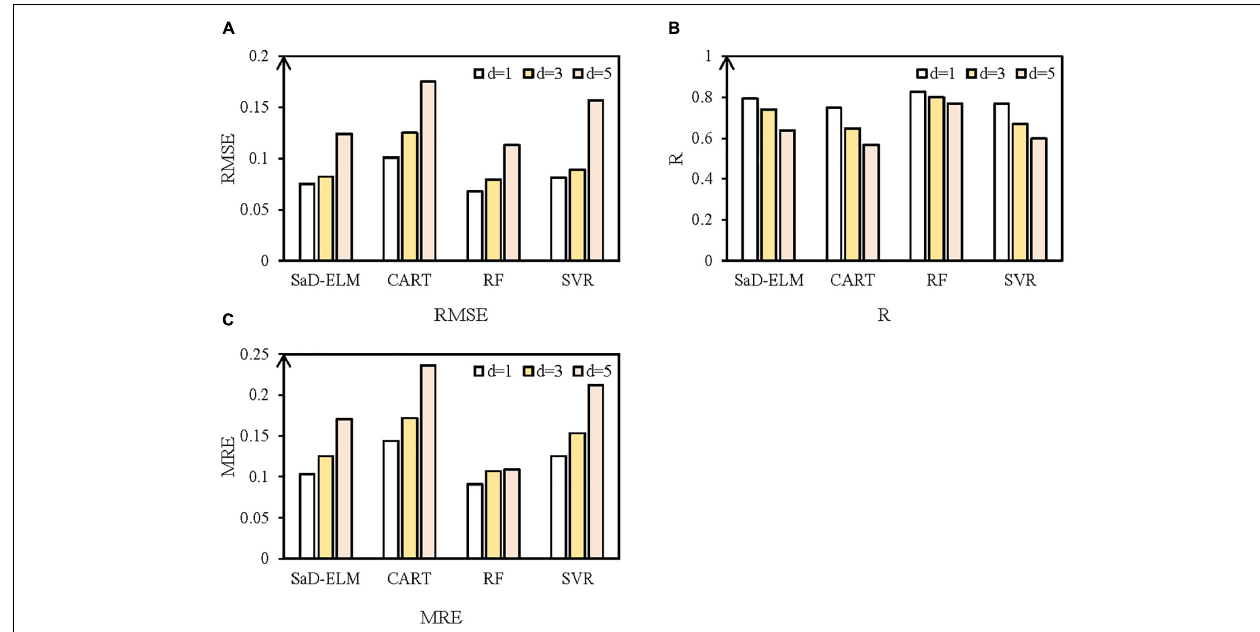
FIGURE 6 | Predicted results with different ML algorithms and lead times. (A) RMSE. (B) R. (C) MRE. White represents prediction in lead time = 1 day; yellow represents prediction in lead time = 3 days; and pink represents prediction in lead time = 5 days.